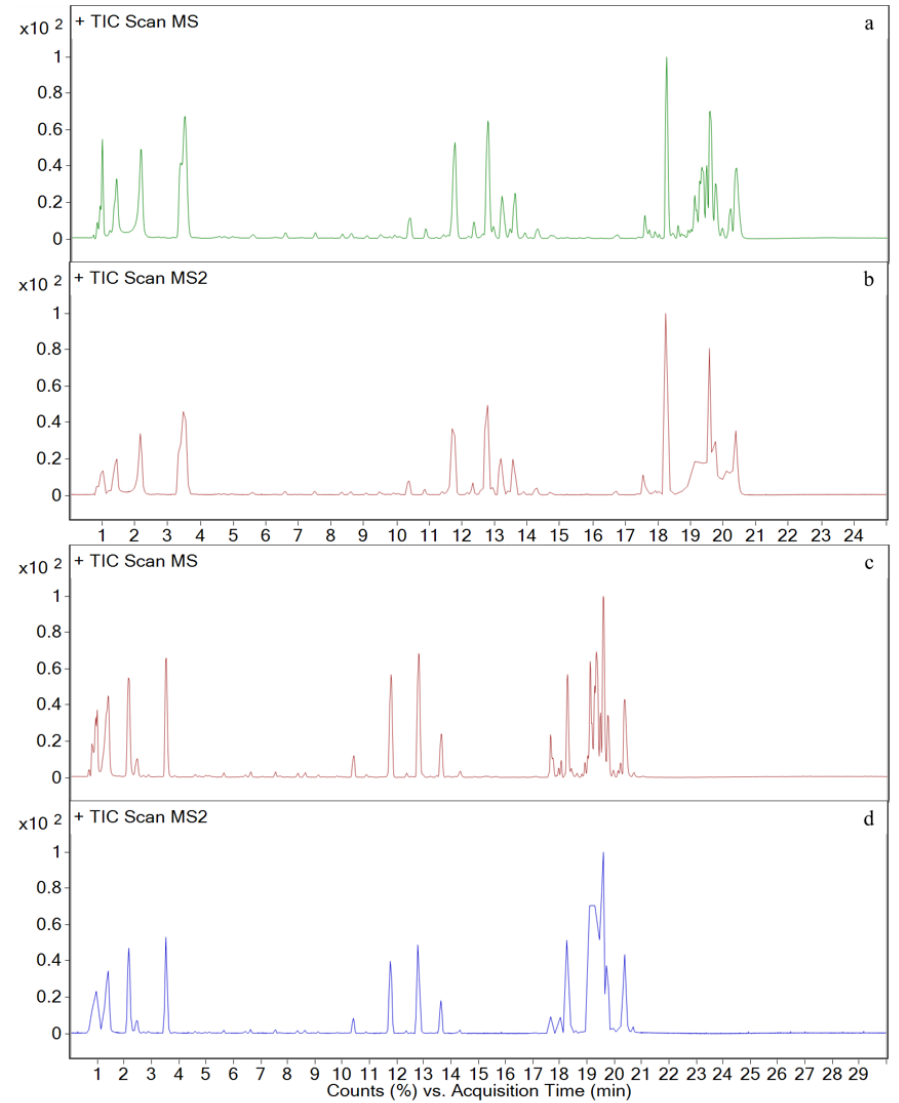
Figure A3. Total ion chromatograms of plasma. ( a , b ) Blank plasma; ( c , d ) Sample plasma.